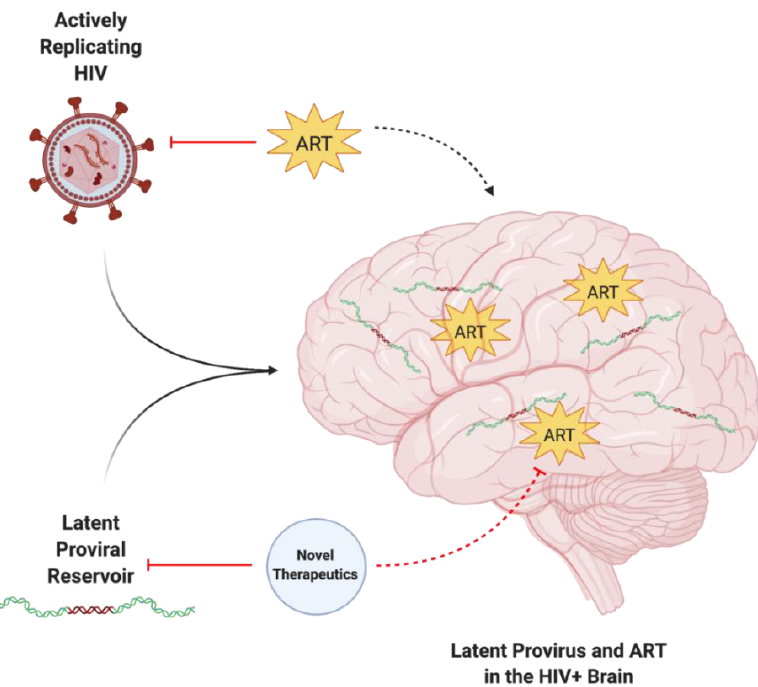
Figure 1. The enigma of persisting latent HIV provirus despite ART. Actively replicating and latent forms of HIV can infiltrate the CNS, resulting in neuroinflammatory pathophysiology. While ART can target active HIV, it is unable to target latent proviral reservoirs. The in-tandem use of ART and novel therapeutic approaches is required to target and eliminate both active and latent HIV within the CNS. Created with BioRender.com. Abbreviations: ART = antiretroviral therapy; HIV = human immunodeficiency virus.